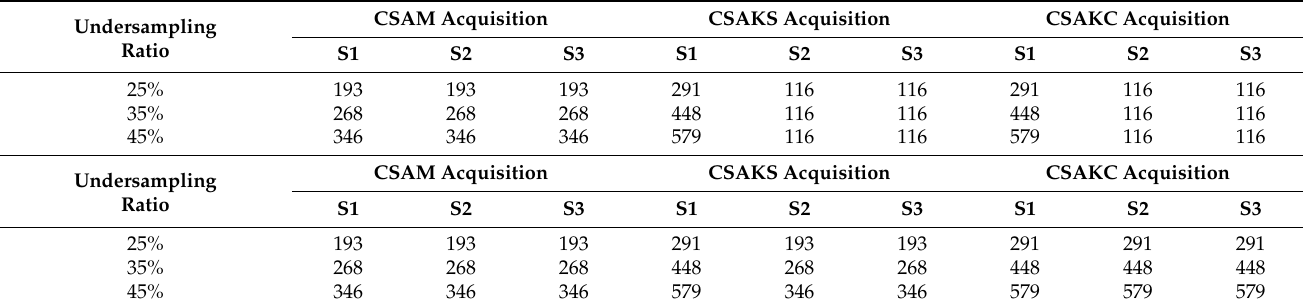
Table 1. Number of k-space lines for MRI data acquisition and reconstruction in CSA techniques. Undersampling